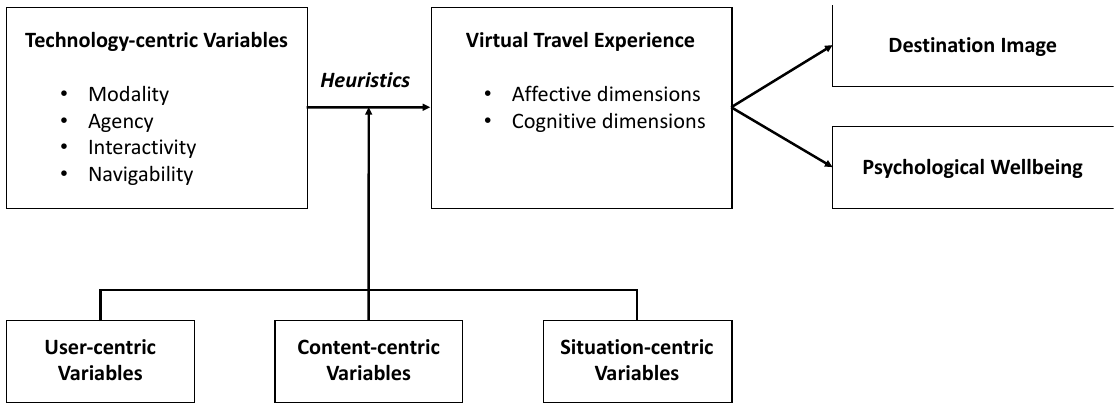
Figure 2. A Framework of Media Technology Effects on Virtual Travel Experience and Destination